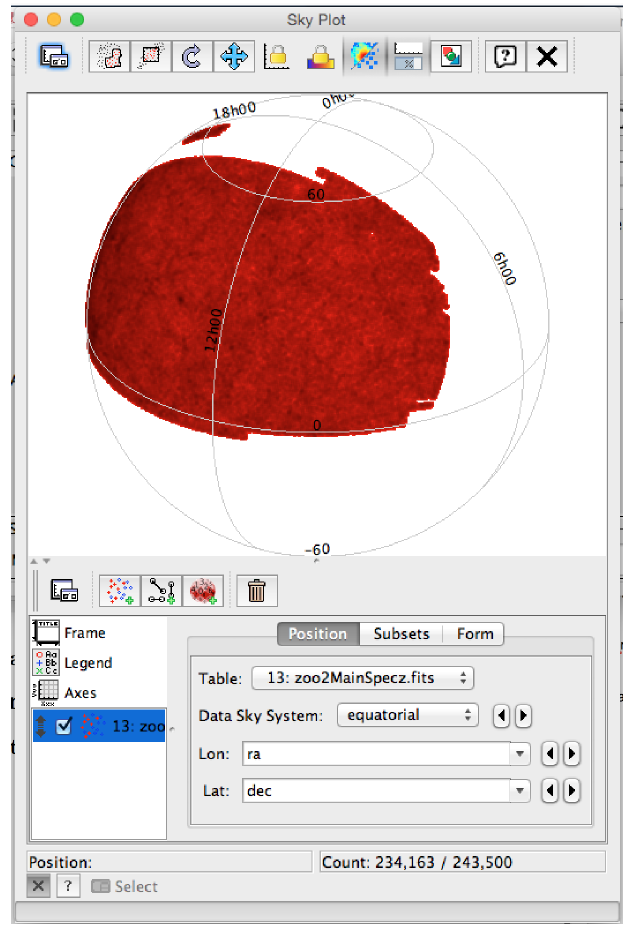
Fig. 54.— The TOPCAT Skyplot